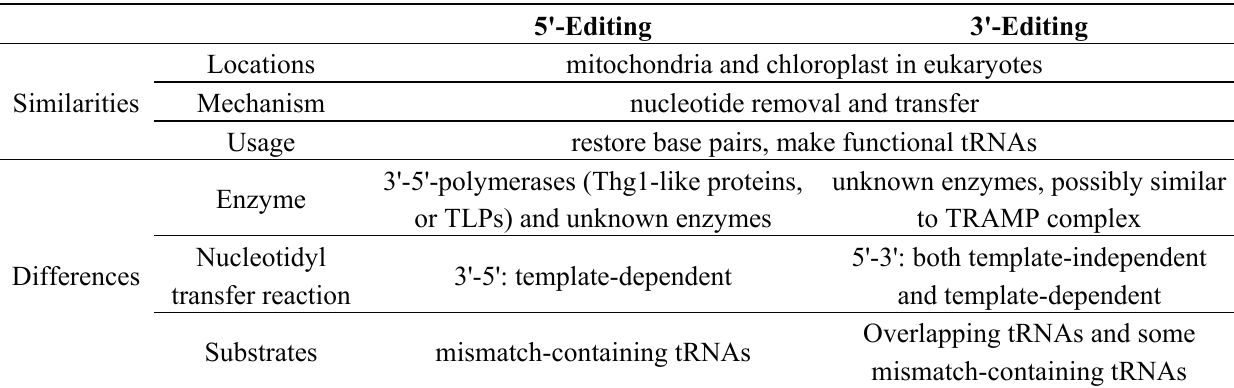
Table 1. Comparison of 5'- and 3'-editing